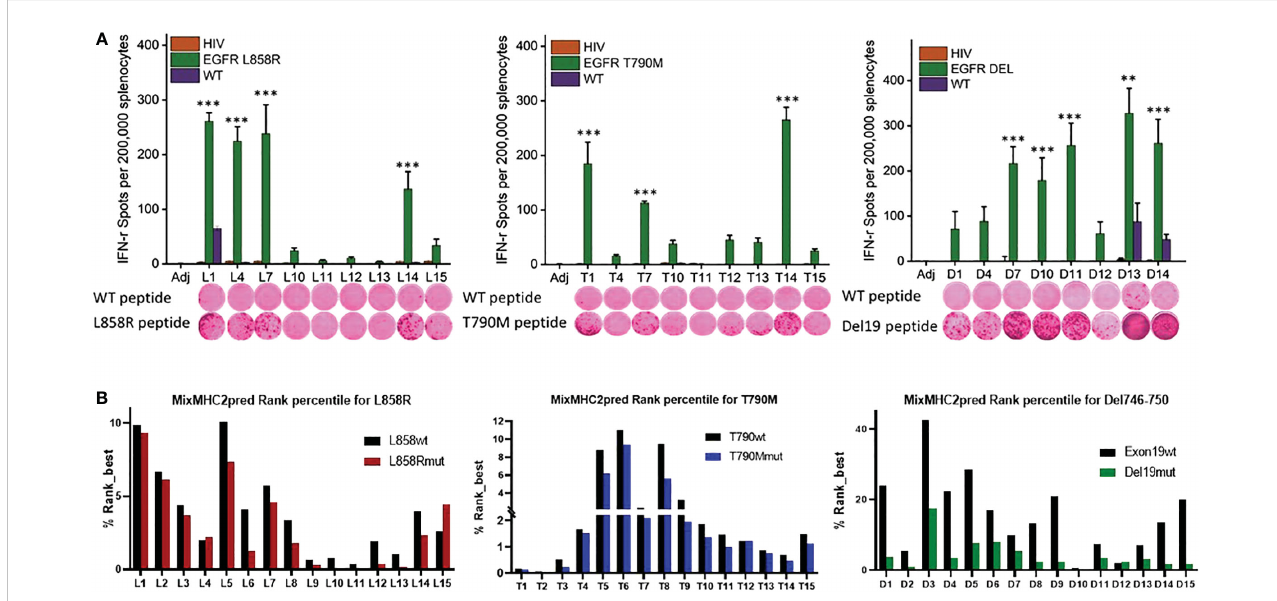
FIGURE 1 Identi fi cation of immunogenic epitopes speci fi c to common EGFR mutations. (A) Quanti fi ed (bars in panels) and representative (inset images) ELISPOT results showing T cell responses from naïve mouse splenocytes stimulated with wild-type peptides ( fi rst row images) or mutation-speci fi c peptides (second row images). Mice were vaccinated 4 times weekly with individual E mut peptides, splenocytes were collected 7 days after the last vaccination, and the splenocytes pulsed with negative HIV control peptide, each EGFR wild type or mutant peptide. After 72h of incubation, ELISPOT assays were performed, plates were scanned, and spot numbers were statistically analyzed. Data are shown as the mean ± SE of three replicate wells per group, n=5, *P ≤ 0.05, **P ≤ 0.01, ***P<0.001. (B) MixMHC2pred prediction for best-ranked peptides speci fi c to L858R (top panel), T790M (middle panel) and Del19 (bottom